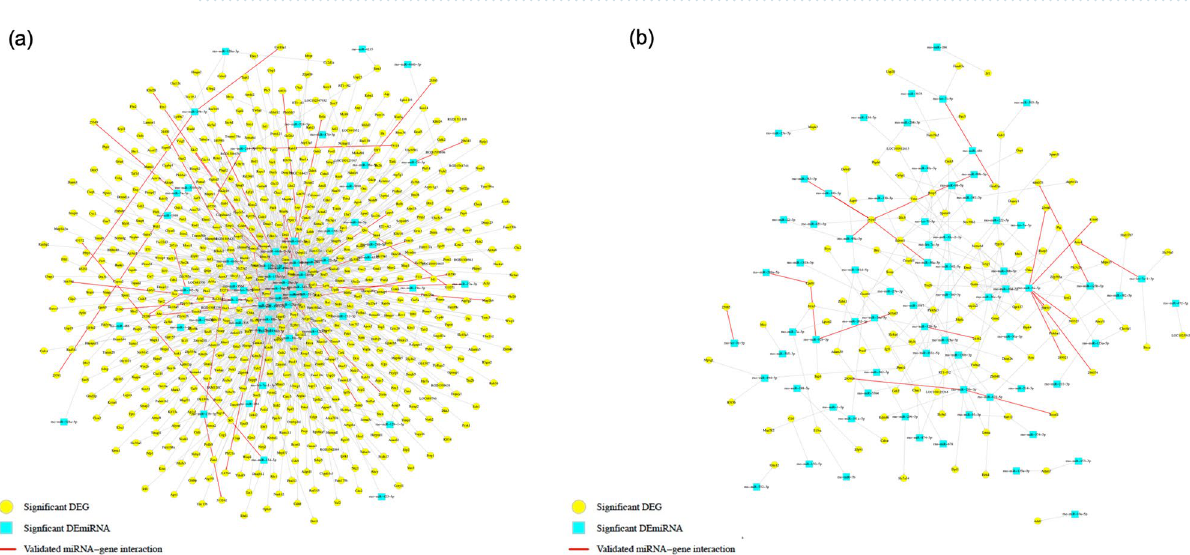
Figure 3. Predicted and validated miRNA-mRNA target network. Using multiMiR, miRNA-mRNA target networks were identified using negative expression correlation following perinatal ( a ) alcohol on DA neurons, and ( b ) alcohol on non-DA neurons. The node shapes (blue square) denote DEmiRs while (yellow circle) denotes DEGs. Red edges suggest validated miRNA-gene network pairs based on existing evidence from the